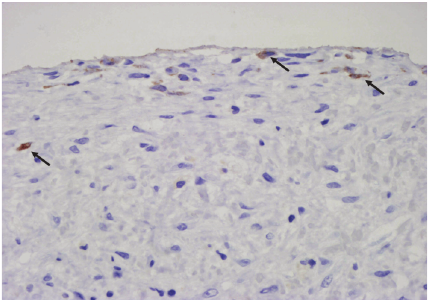
Figure 2: Evidence of MMT in EPS. Light microscopy analysis of a parietal peritoneal biopsy from a patient with EPS. Despite sig- nificant denudation of the peritoneal membrane, a submesothelial cytokeratin staining (brown) in submesothelial area is observed. Thiscytokeratinstainingsuggeststhesuperficialprecedenceofthese cells (arrows). Magnification ×